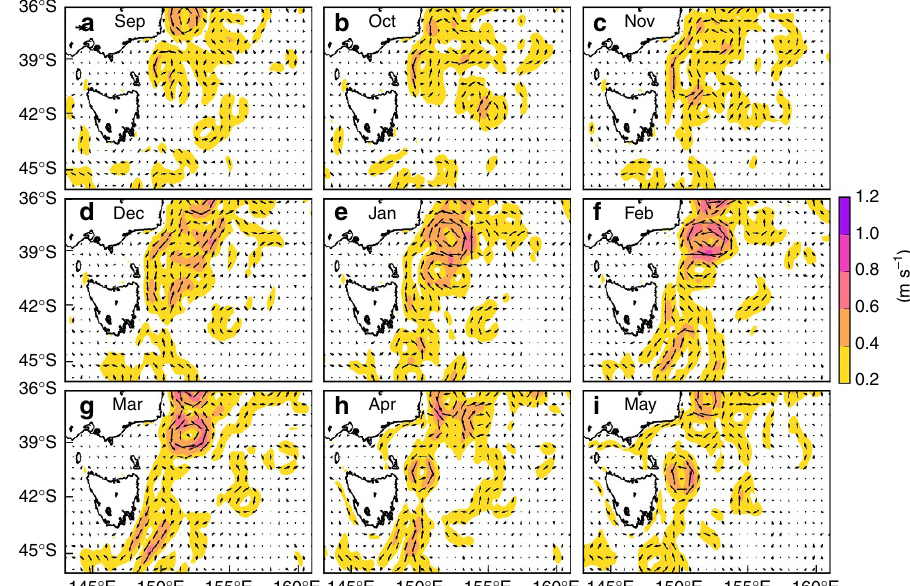
Figure 4 | Monthly mean surface currents off southeastern Australia from September 2015 to May 2016. Ocean current data is IMOS OceanCurrent. Currents are shown monthly for ( a-i ) Sep 2015 through May 2016. A reference arrow of 0.5ms (cid:3) 1 shown in upper left of ( a ) and colours indicate current